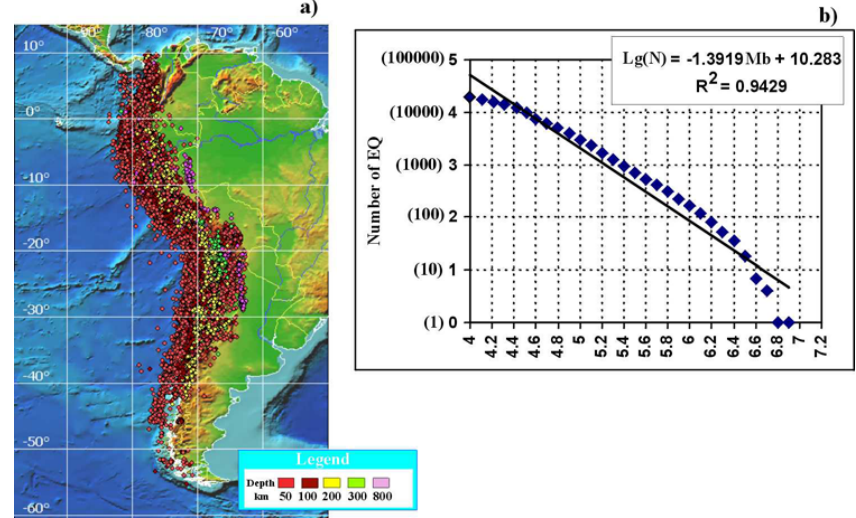
Figure 2. Plot a) is the map of the South America with events under study (small circles); the color of each circles depends on source depth; plot b) is the Gutenberg-Richter power-low relationship for seismic events in studied part of the South America.